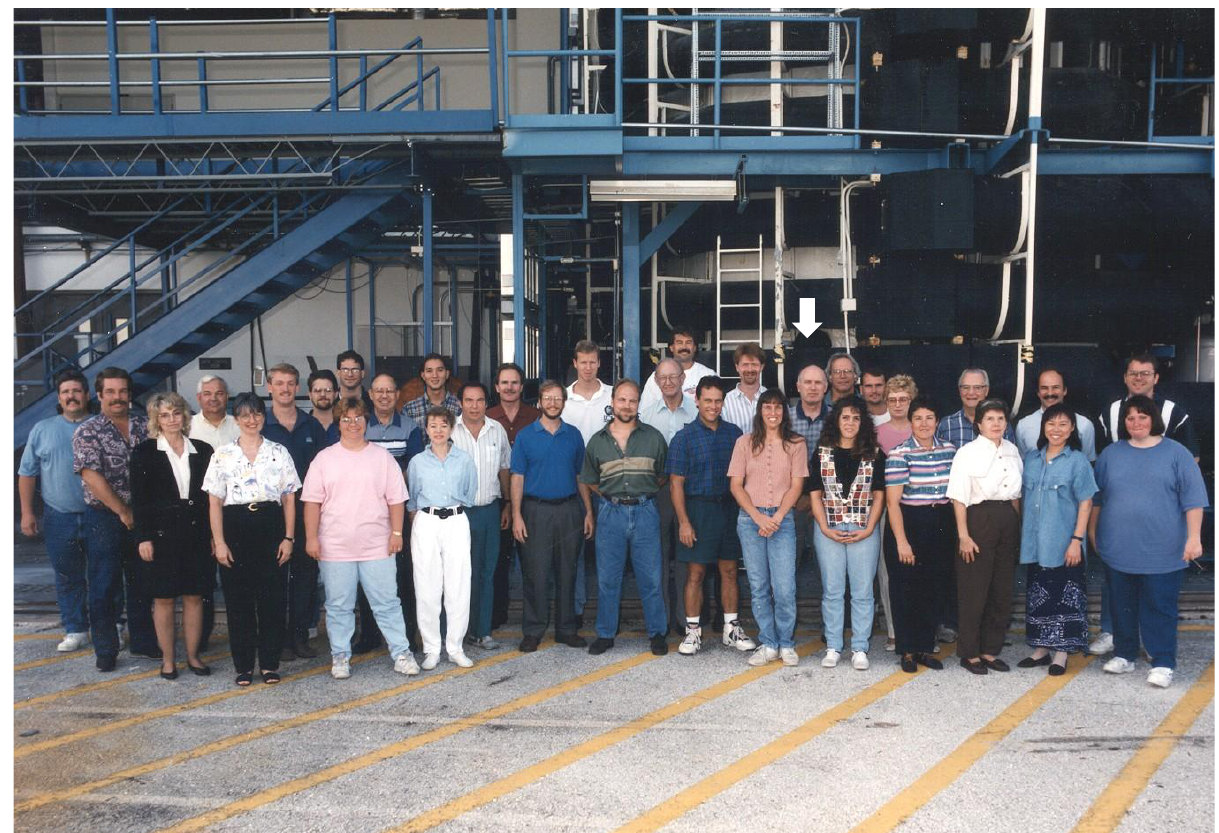
Figure 4. NASA’s Advanced Life Support research team working at Hangar L at Kennedy Space Center, Florida in 1994. The Biomass Produc- tion Chamber is visible behind the group. Dr. Bill Knott, founder of Kennedy Space Center’s life science research is the 12 th person from the right side of the photo (see white arrow), directly behind Lisa Ruffe and Dr. Cheryl Mackowiak, horticultural researchers. The author is the fourth person from the right. Photo provided by